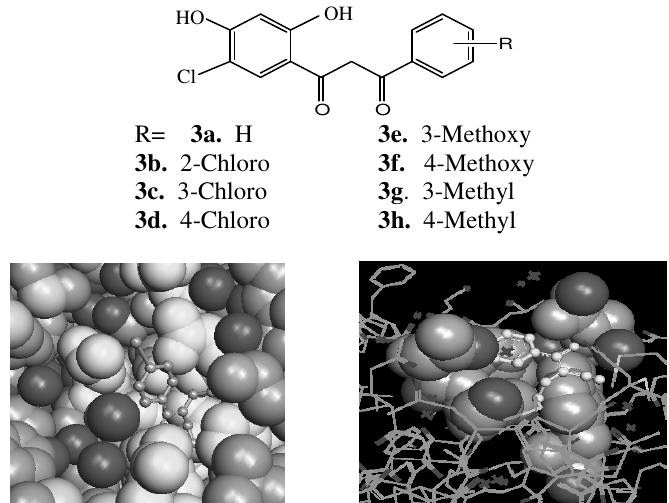
Figure 1. 1-(2', 4'-Diydroxy-5'-chlorophenyl)-3-(4"-methoxyphenyl)-propane-1,3-dione ( 3f ) in the active site of cytochrome P450 reductase using Argus & Genetic algorithms having binding free energies -8.68 and -9.24 kcal/mole